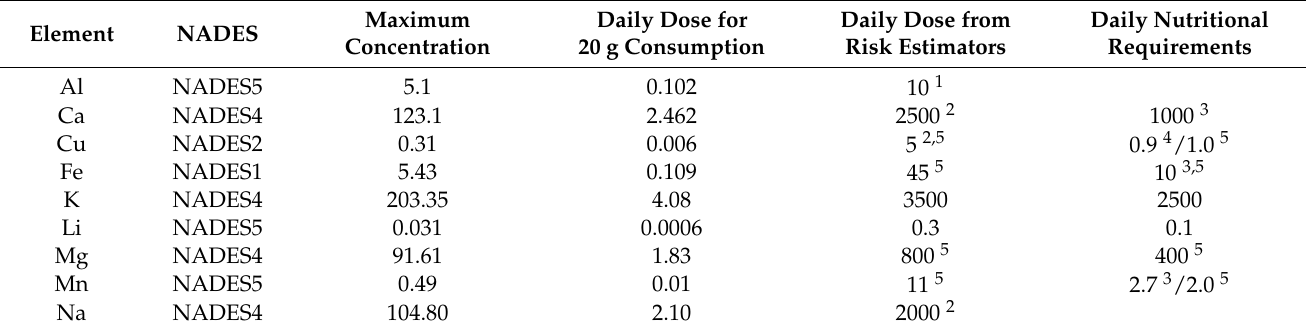
Table 3. Element maximum concentration (mg/kg), its daily dose (mg/day) in the extracts from G. glabra , and comparison with daily dose risk estimators for a 70-kg man and nutritional